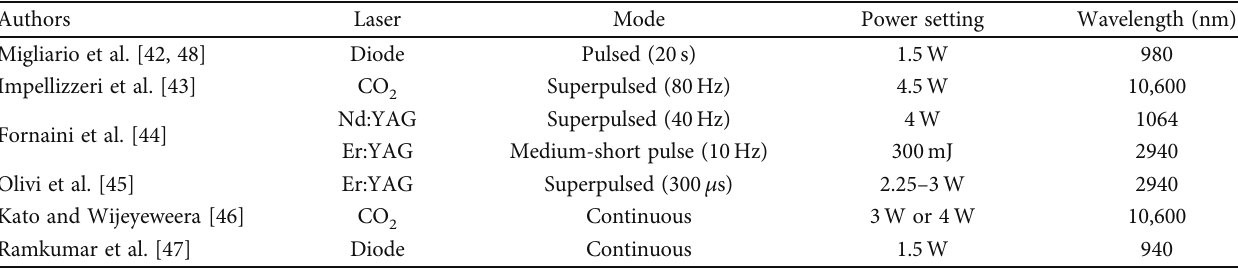
Figure 8: (a – c) Intraoral photo and (d) panoramic radiograph 12 month after surgical-orthodontics disinclusion. Upper canine 2.3, once included, is positioned in the dental arch. Table 3: Brief review of the dosimetry and techniques used in previous clinical